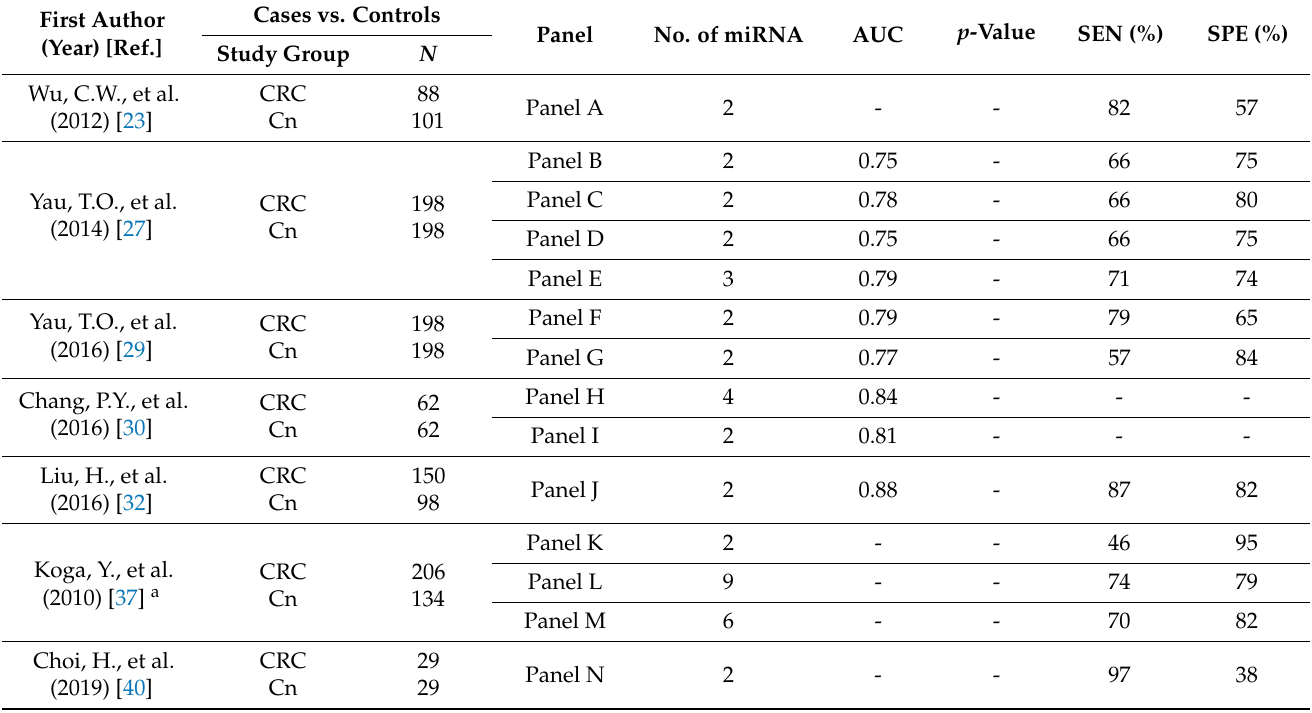
Table 2. Diagnostic performance of fecal miRNA panels for